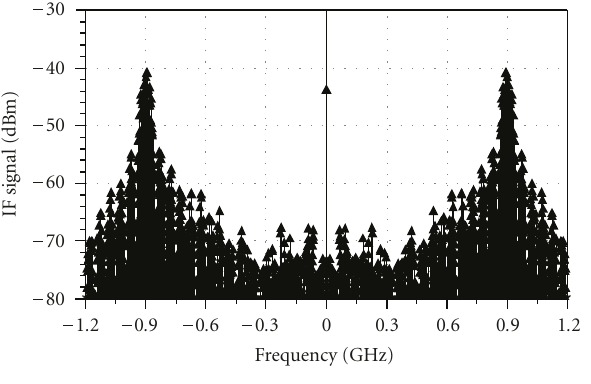
Figure 10: Typical spectrum of the IF signal.